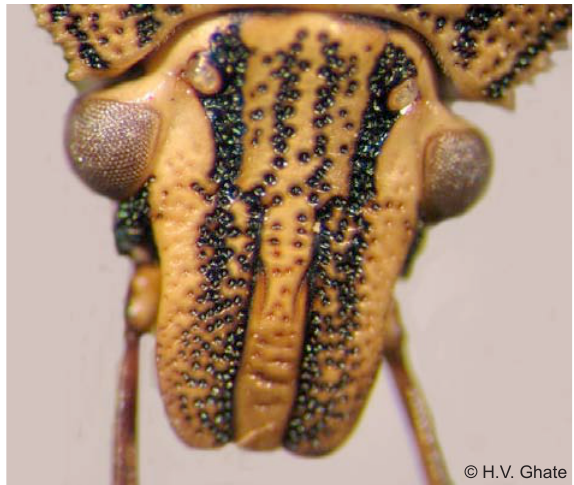
Image 2. Andrallus spinidens head, dorsal view showing a pattern of black punctures, large eyes and more or less elongated head